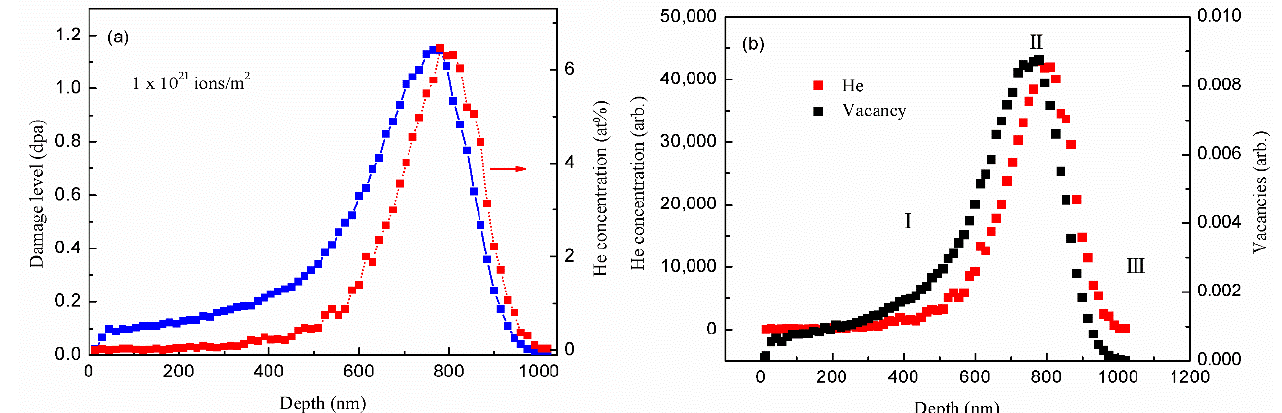
Figure 1. Depth profiles of the displacement damage ( a ), helium concentration distribution and vacancies ( b ) in irradiated samples with helium ions to a fluence of 1 × 10 21 ions/m 2 (I, II and III represent three regions).